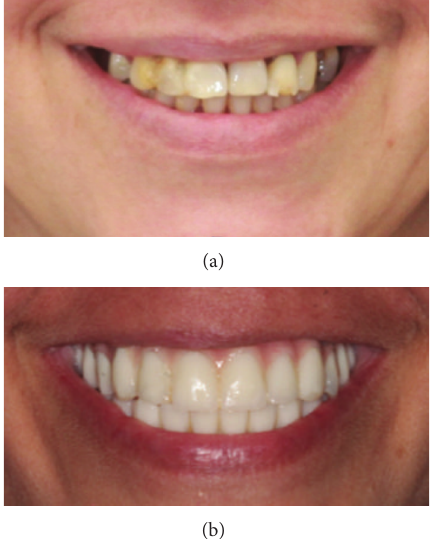
Figure 11: Photographs show patient’s smile. (a) Pre-treatment. (b) During